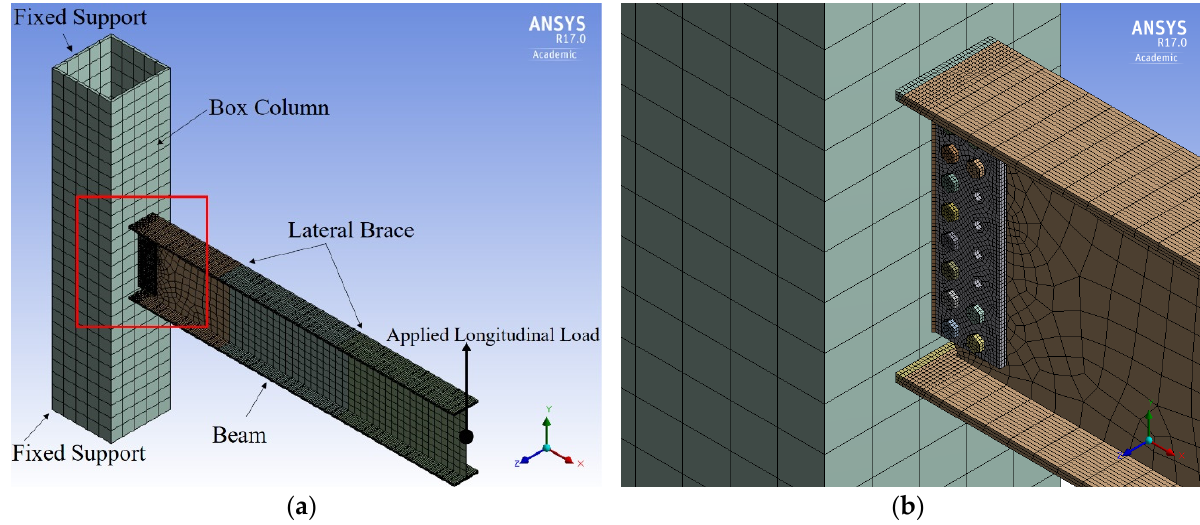
Figure 1. FEM model of a full-scale steel H-beam-to-box-column connection; ( a ) boundary conditions and mesh, ( b ) BWWF